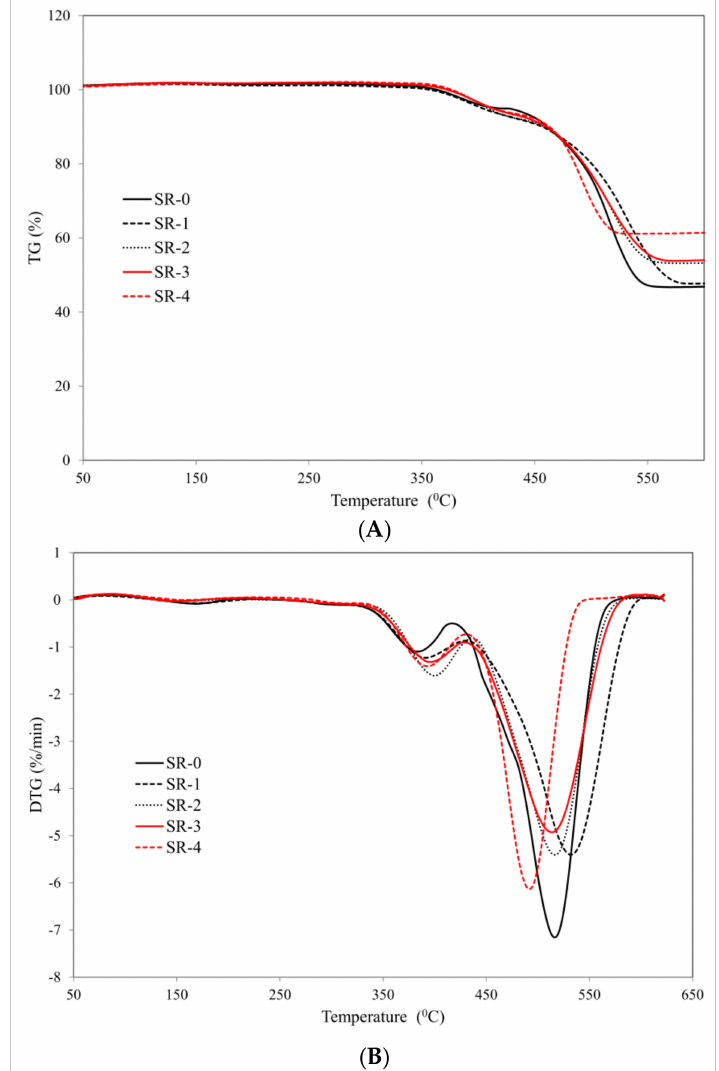
Figure 4. Thermal curves: ( A ) TG ( B ) DTG of studied